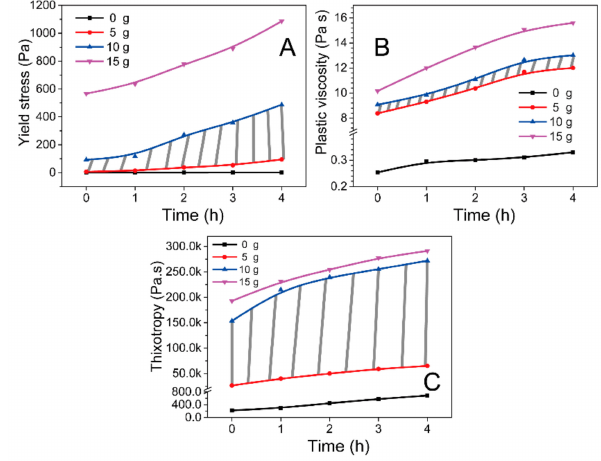
Figure 3. E ff ect of CMS on the evolution of yield stress ( A ), plastic viscosity ( B ) and thixotropy ( C ) with working